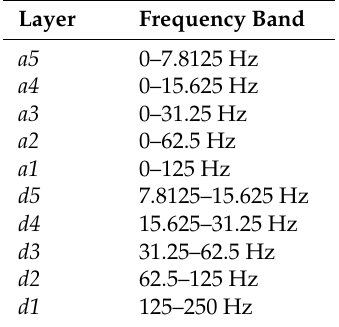
Table 1. The frequency band of each layer by wavelet decomposition.